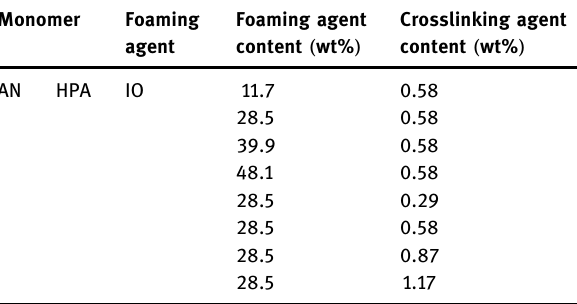
Table 1: Formulation of high - temperature thermally